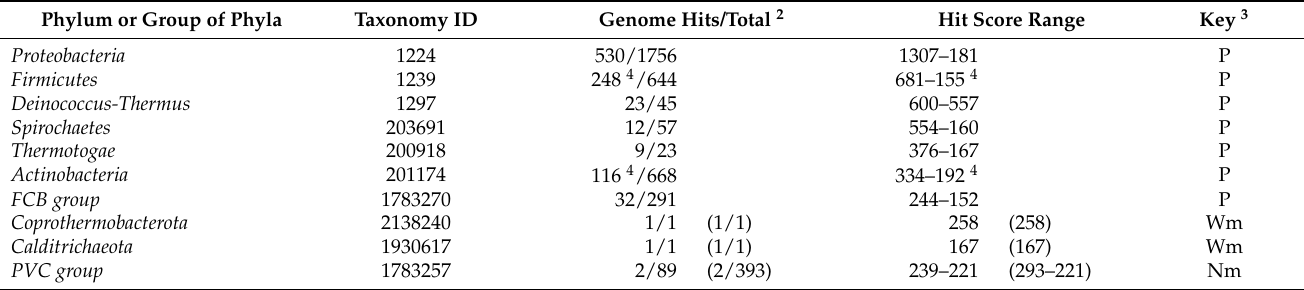
Table 2. Distribution of cpdB -like genes in different phyla or groups of phyla of the superkingdom Bacteria , as obtained by TblastN analysis using S. enterica CpdB as the query 1